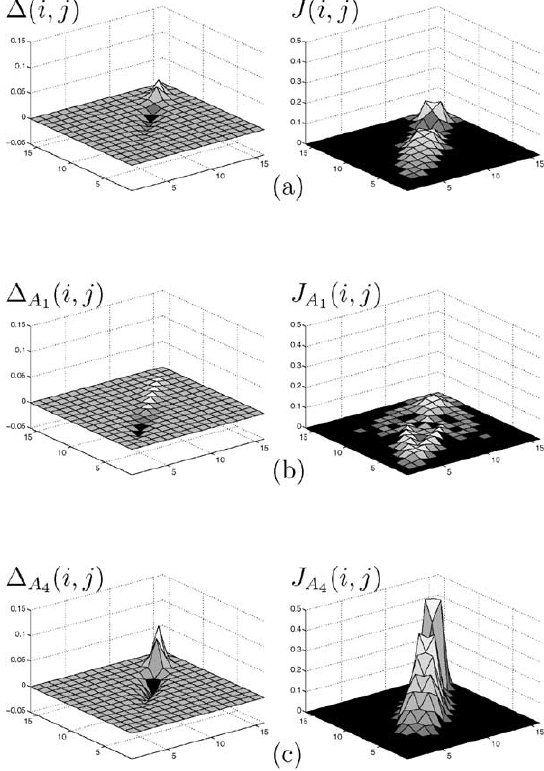
Fig. 5. Gray Level Cooccurrence Matrix (GLCM) Mahalanobis class distance matrices J ( i , j ) and GLCM class difference matrices ∆ ( i , j ) between the two prognostic classes of early ovarian cancer, com- puted from nuclear images with non-standardized first-order gray level statistics. The matrices were computed from (a) all 37,690 nu- clei, (b) all nuclei within area interval A 1 (1000 (cid:1) nuclear area < 2000 pixels) and (c) all nuclei within area interval A 4 (4000 (cid:1) nuclear area < 5000 pixels). The positive (negative) values in the difference matrices correspond to GLCM matrix elements that are more (less) probable for the good prognosis class compared to the poor prognosis class. The matrices were computed from the 70% central part of the